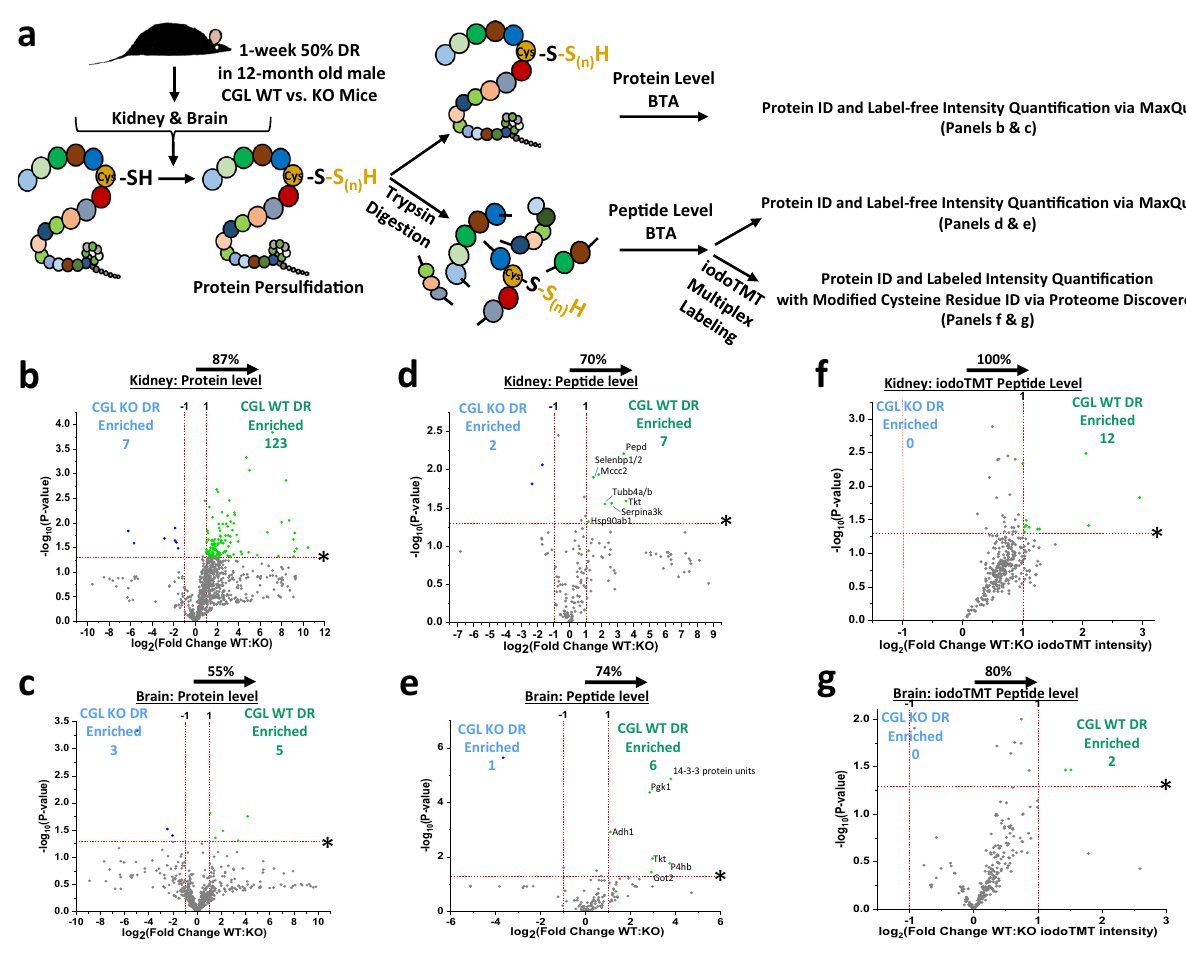
Fig. 9 Orthogonal protein and peptide-based biotin thiol assay (BTA) approaches show CGL dependence for DR-induced persul fi dation shifts. a Graphical presentation of experimental setup. Kidney and brain extracts from 12-month-old CGL WT and KO mice under 1 week 50% DR were subjected to protein level or peptide level BTA, LC-MS/MS, and analyzed via the given software platform ( n = 3 mice/group). Furthermore, an additional peptide level BTA was subjected to iodoTMT labeling prior to LC-MS/MS for quanti fi cation and site-level analysis of cysteine residues ( n = 3 mice/group). b – g Volcano plots showing CGL-dependent intensity shifts in DTT-eluted & unlabeled ( b – e ) or TCEP-eluted & iodoTMT labeled ( f , g ) persul fi dated proteins. b , c Derived from unlabeled protein level BTA for kidney ( b ) and brain ( c ). d , e Derived from unlabeled peptide level BTA for kidney ( d ) and brain ( e ). f , g Derived from iodoTMT labeled peptide level BTA for kidney ( f ) and brain ( g ). The log 2 (Fold Change WT:KO) X-axis displays the average fold change in intensity for each protein, and the − log 10 Y-axis displays the calculated P value from a two-sided Student ’ s t test when comparing the individual intensity values for each protein from WT versus KO mice. The non-axial red dotted vertical lines highlight the biological signi fi cance threshold of + / − twofold change in intensity, while the non-axial red dotted horizontal line with asterisk highlights the statistical signi fi cance threshold of P < 0.05. Blue (KO enriched) and green (WT enriched) dots indicate proteins reaching both biological- and statistical-thresholds. The percentage and direction of proteins skewed toward CGL WT is provided above the tissue label. See also Supplementary Fig.